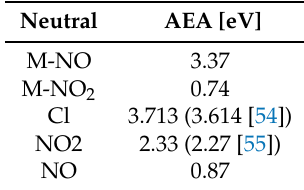
Table 2. Electron affinities of the main decomposition products of 5-nitro-2,4-dichloropyrimidine, as obtained on DFT B3LYP/6-31+G(d) level of theory in Gaussian [42] and literature values in